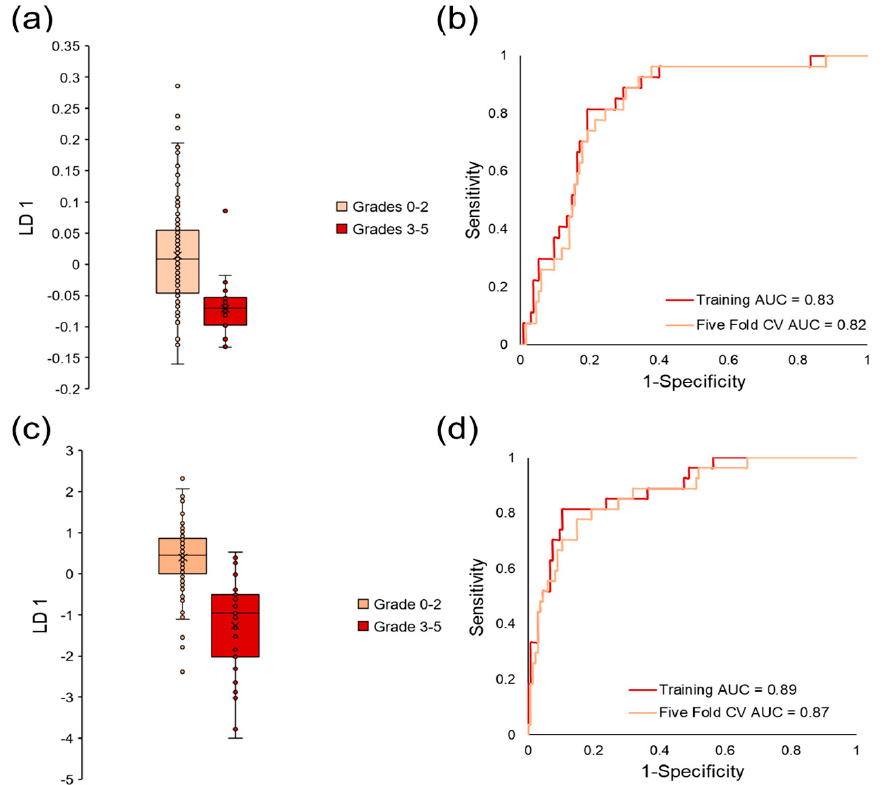
Figure 6. Supervised multivariate analysis of human urine to identify a biosignature of VOCs that could classify aggressive prostate cancer through LDA. ( a ) LD 1 scores for a model of six urinary volatiles that could classify aggressive tumors with ( b ) ROC AUC equal to 0.83 in the training data set and 0.82 in the cross-validated data set. ( c ) LD 1 scores for an alternative model of seven urinary VOCs that could stratify aggressive prostate cancer with ( d ) ROC AUC equal to 0.89 in the training data and 0.87 in the cross-validated data set.